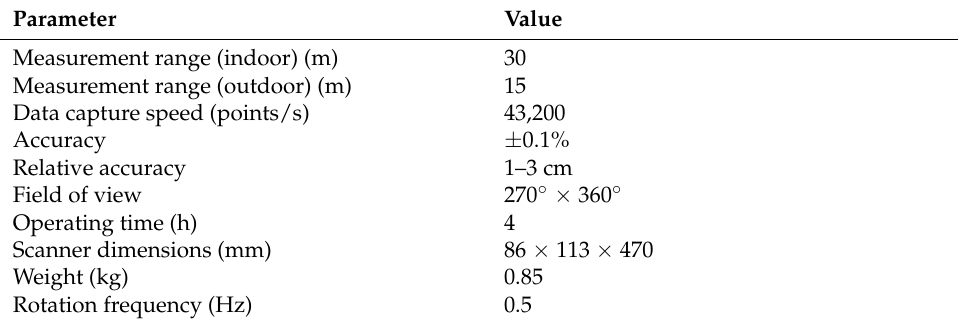
Table 1. Technical specifications of the WMMS used in this